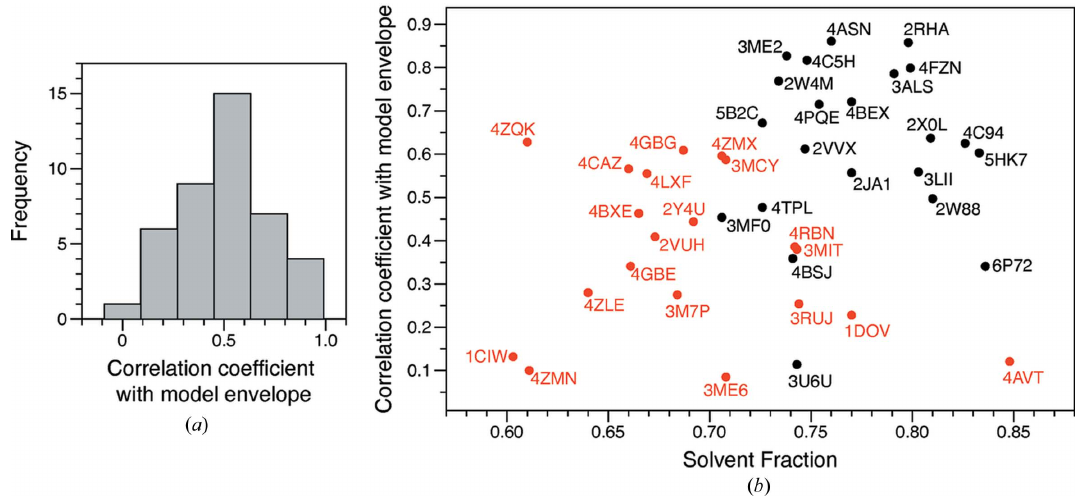
Figure 3 Overall results of envelope clustering. ( a ) The distribution of the correlation coefficient between the best consensus molecular envelope and the model envelope, for all 42 test cases (allowing for envelope inversion). ( b ) Scatter plot showing the correlation coefficient between the best consensus envelope and the model envelope as a function of crystal solvent content. PDB identifiers of the 42 test cases are indicated. Points colored black are the 22 data sets for which phases were subsequently successfully retrieved, points colored red are the 20 data sets for which phase retrieval was